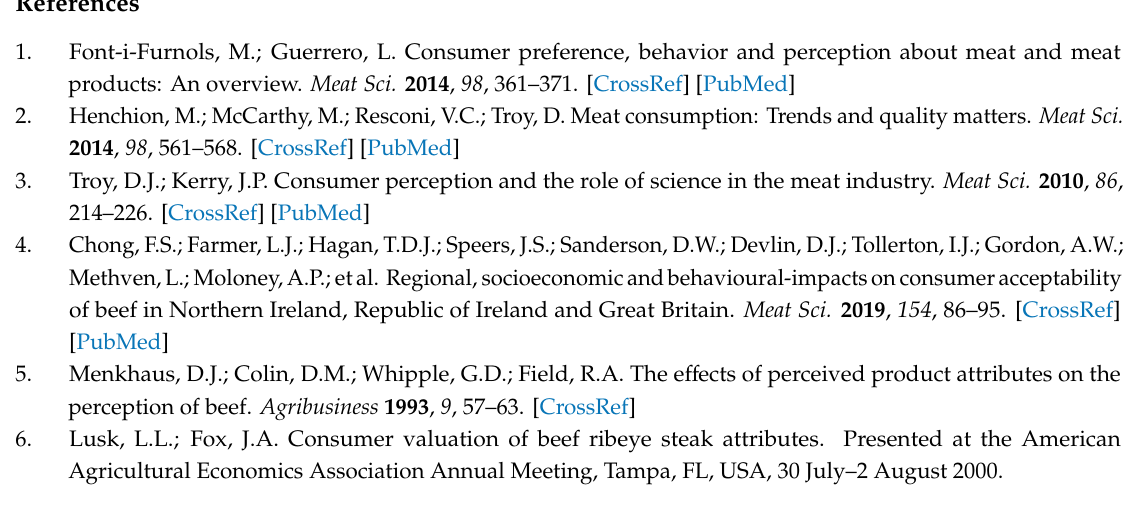
Figure S1: Scatter plot illustrating the relationship between raw flavor data plotted against satisfaction. 0 = dislike flavor / overall extremely; 100 = like flavor / overall extremely, Figure S2: Scatter plot illustrating the relationship between flavor data cleaned with Cook’s Distance method plotted against satisfaction. 0 = dislike flavor / overall extremely; 100 = like flavor / overall extremely, Figure S3: Scatter plot illustrating the relationship between raw tenderness data plotted against satisfaction. 0 = dislike flavor / overall extremely; 100 = like flavor / overall extremely, Figure S4: Scatter plot illustrating the relationship between tenderness data cleaned with Cook’s Distance method plotted against satisfaction. 0 = dislike flavor / overall extremely; 100 = like flavor / overall extremely, Figure S5: Scatter plot illustrating the relationship between raw juiciness data plotted against satisfaction. 0 = dislike flavor / overall extremely; 100 = like flavor / overall extremely, Figure S6: Scatter plot illustrating the relationship between juiciness data cleaned with Cook’s Distance method plotted against satisfaction. 0 = dislike flavor / overall extremely; 100 = like flavor / overall